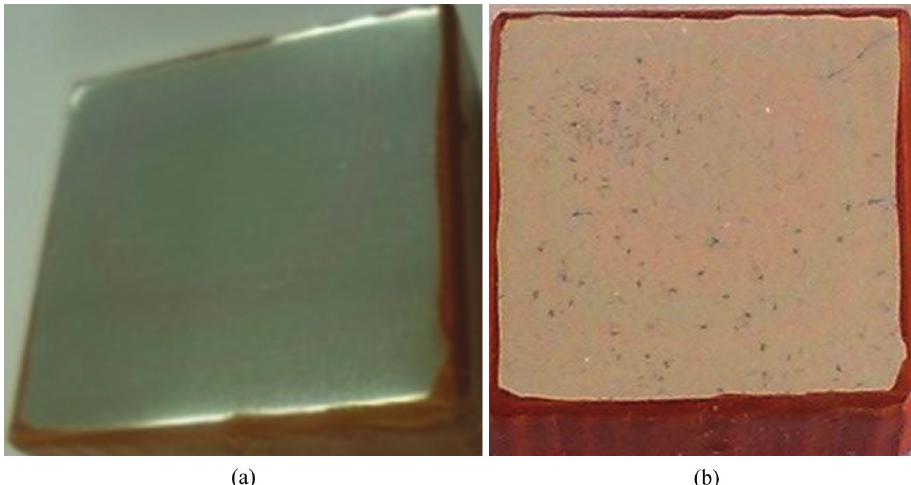
Figure 11. (a) Surface of the sample containing the film deposited in plasmas of 20 W of power, before the test and (b) after 145 h of exposure to salt spray.